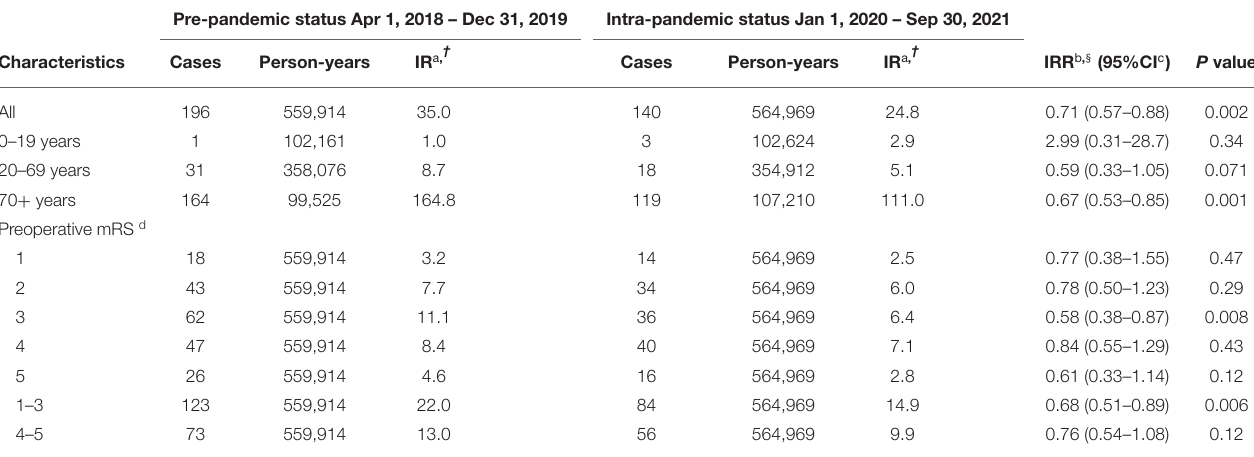
TABLE 2 | Incidence of chronic subdural hematoma according to pre- and intra-pandemic status in Akashi city,